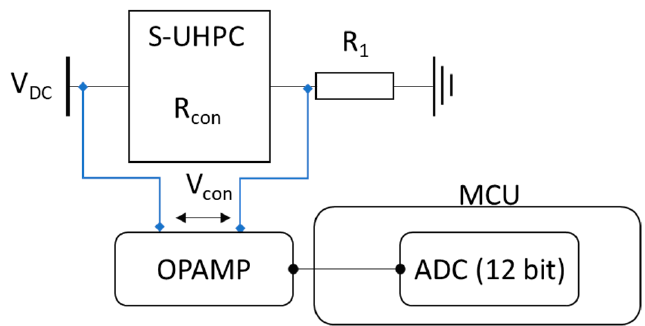
Figure 1. Block diagram of the resistance sensing circuit.